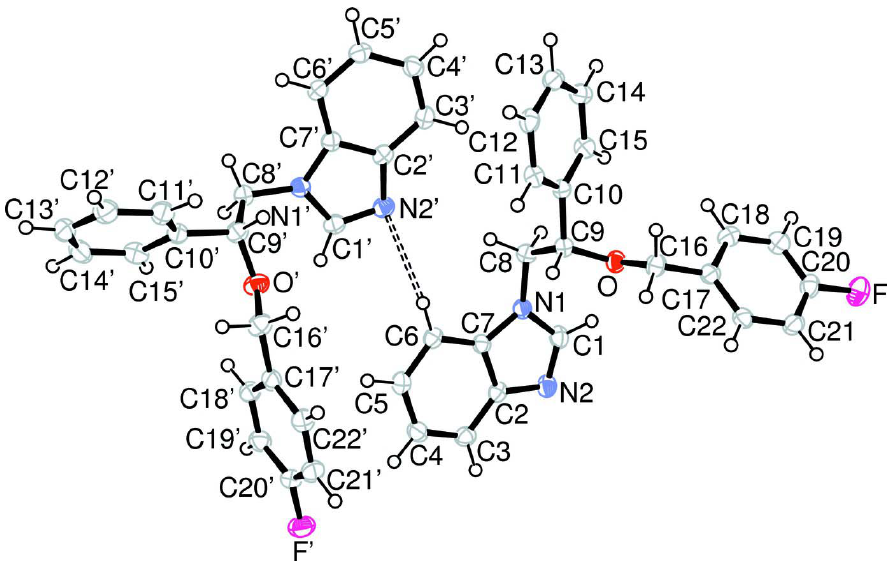
Figure 1 The molecular structure of the title molecule with the atom-numbering scheme. Displacement ellipsoids are drawn at the 50% probability level. Hydrogen bond is shown as double dashed line.